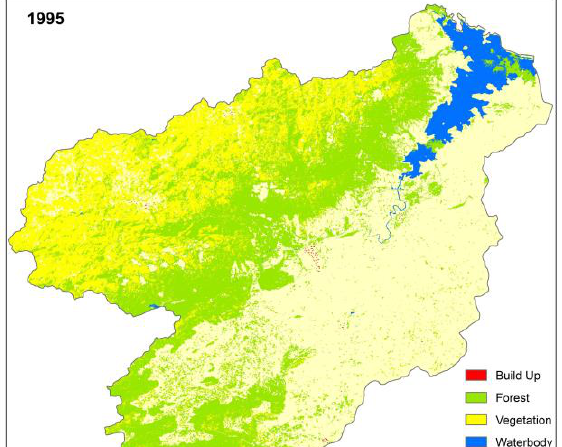
Figure 8: Land use 1995